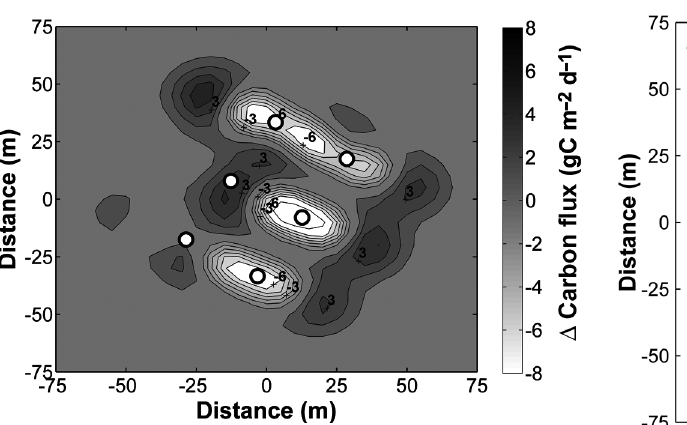
Fig. 7. C flux anomalies (g C m −2 d −1 ) induced by a change in the feed provided, the new feed being characterized by a lower sedimentation velocity